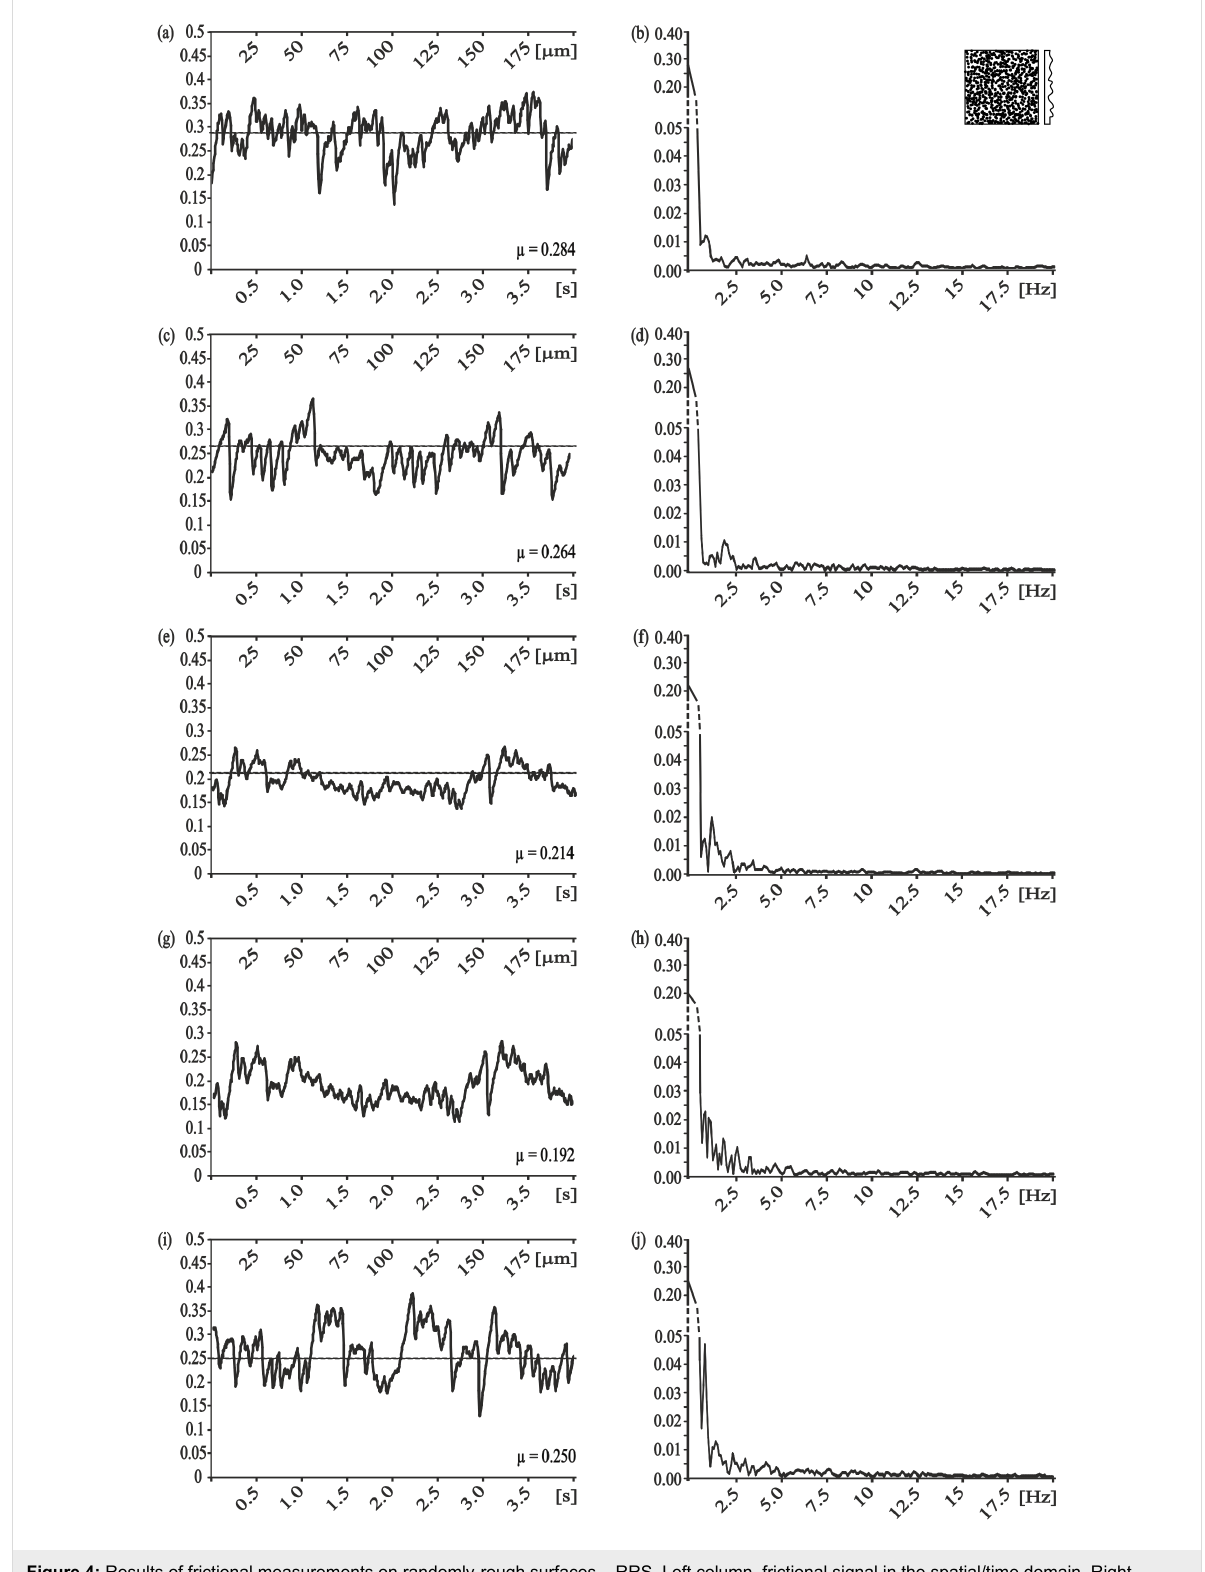
Figure 4: Results of frictional measurements on randomly-rough surfaces – RRS. Left column, frictional signal in the spatial/time domain. Right column, frictional signal in the frequency domain after FFT; the ordinate shows the single-sided amplitude spectrum - SSAS. Grain size of RRS: a,b) 0.3 µm, c,d) 1 µm, e,f) 3 µm, g,h) 9 µm, i,j) 12